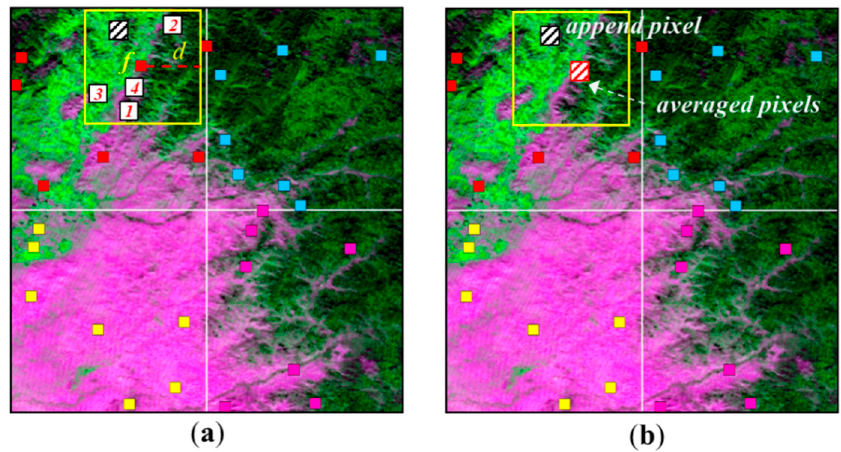
Figure 4. Update candidate endmembers pixels, where f is central pixels, and d is search distance. ( a ) the spectral diversity between the pixel marked with a number from 1 to 4 and the central pixel is less than 𝜔 , and the pixel filled with a slash is higher than 𝜛 . ( b ) those pixels with enormous spectral diversity and the central pixels are appended into the candidate endmember pixel set and all spectral vector pixels are averaged with the smallest spectral variety.